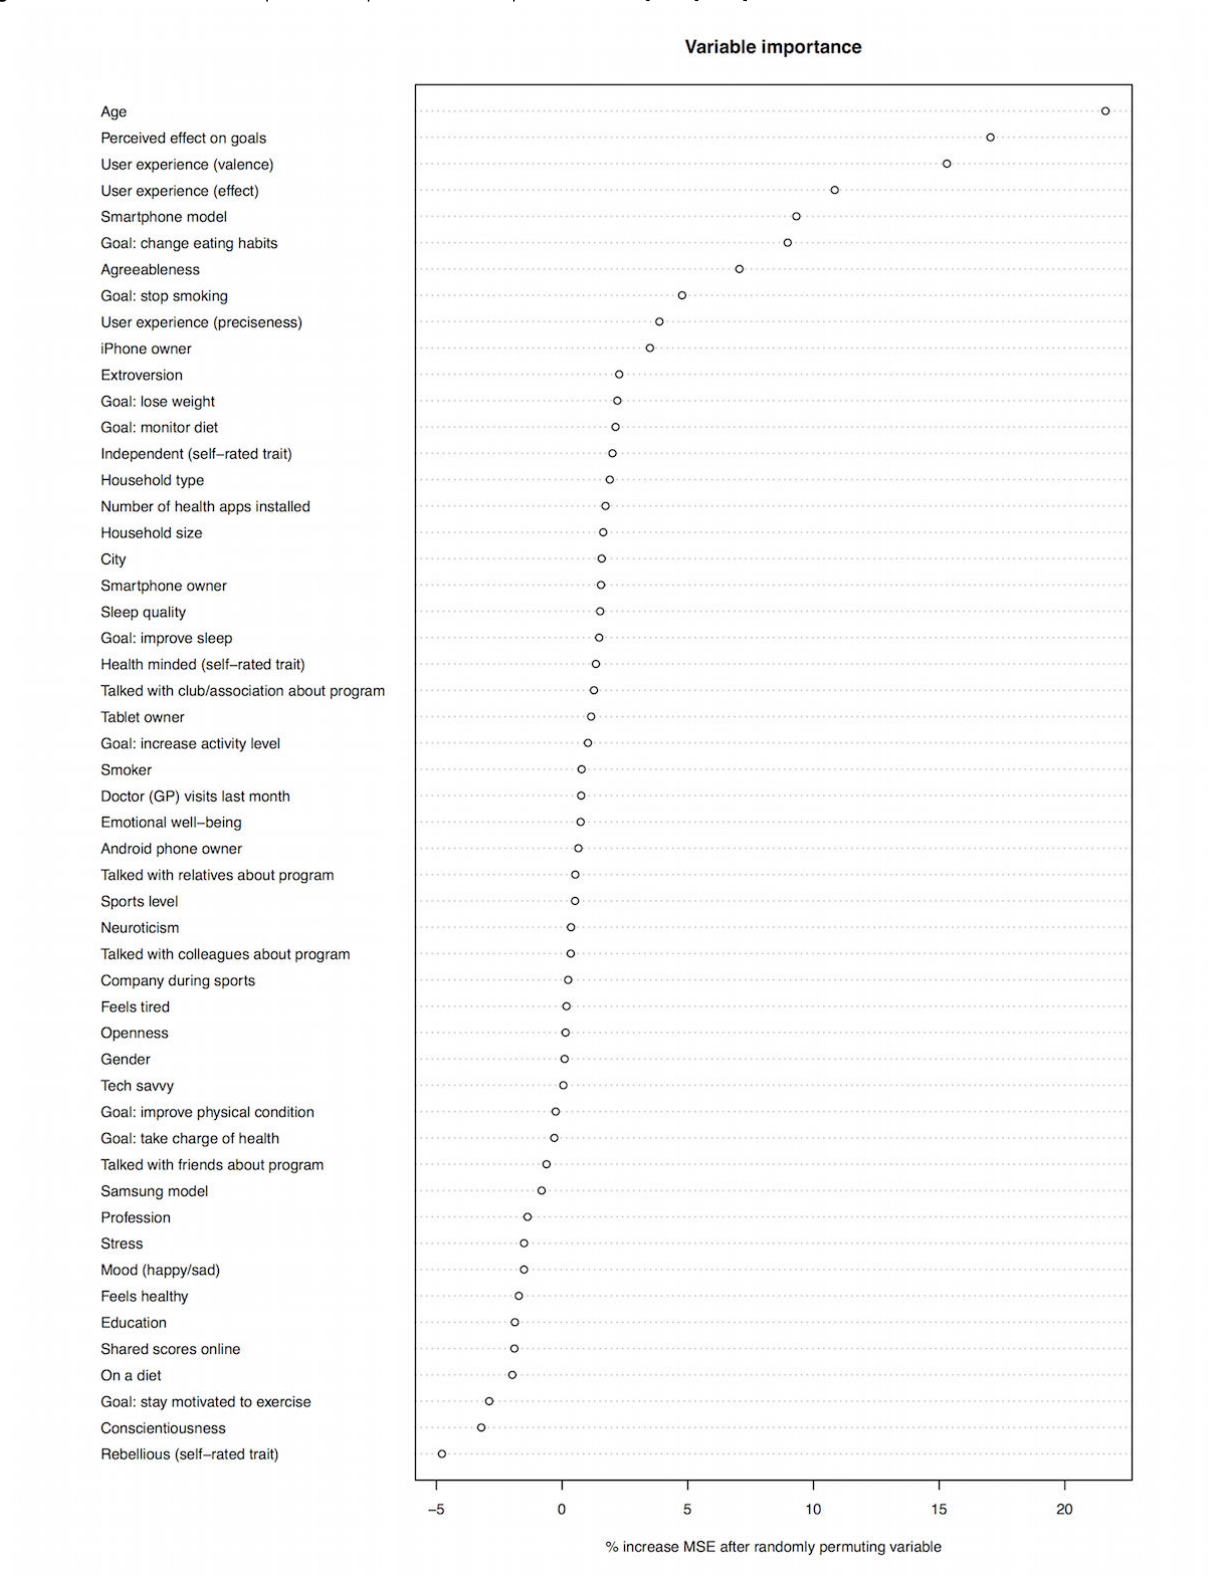
Figure 10. Plot of the relative importance of predictors in all questionnaires (Q1 + Q2 +